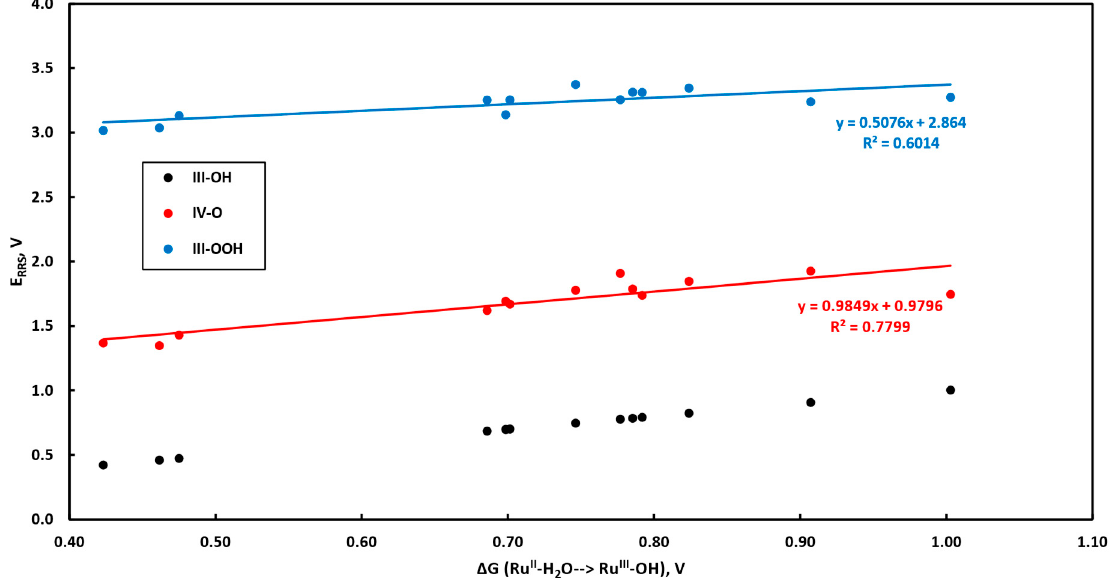
Figure 3. Free − energy scaling relationships for E RRS of Ru III − OH, Ru IV = O, and Ru III − OOH for the thirteen molecular catalysts considered in this study.